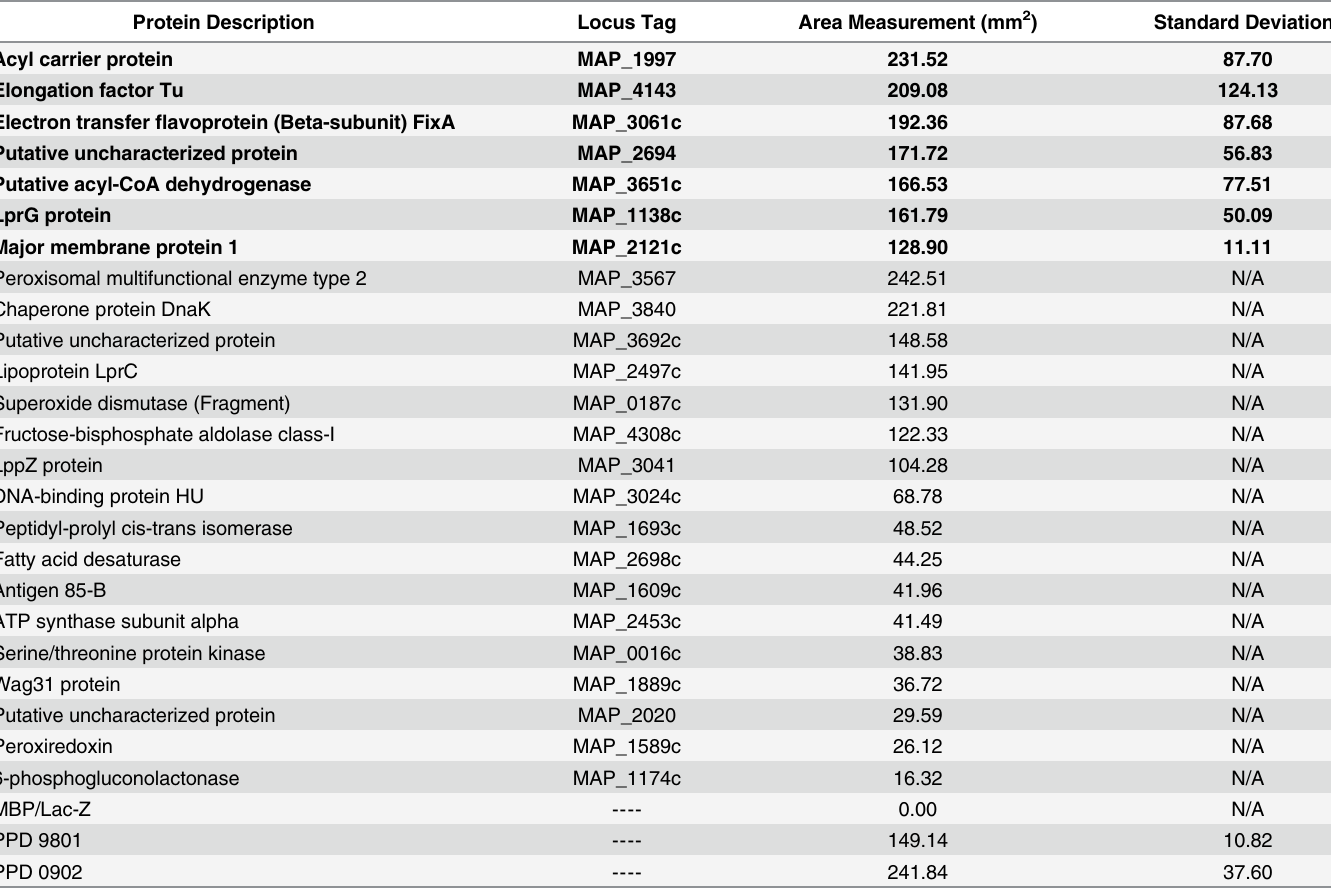
Table 3. Positive skin test responses in a guinea pig potency test of 24 MAP recombinant proteins from 47 total proteins